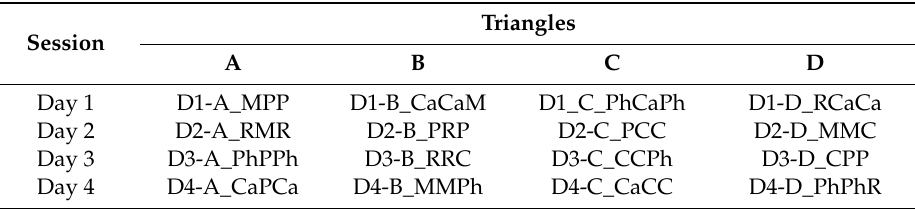
Table 3. Sensorial triangle codes for each session.